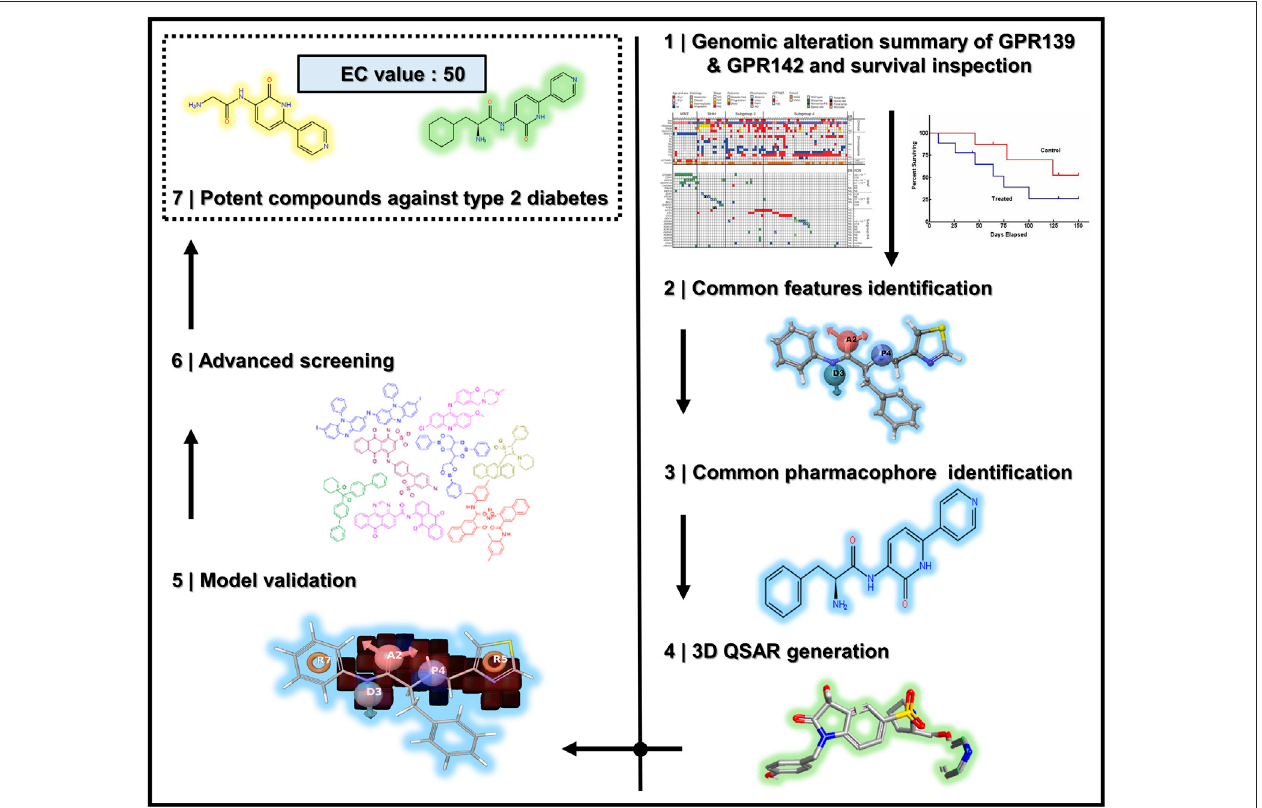
FIGURE1| Theoverallwork fl owofthestepstakenforthesuccessfulpharmacophore ’ sperception,3DQSARmodeldevelopment,and3Ddatabasescreeningfor GPR142.